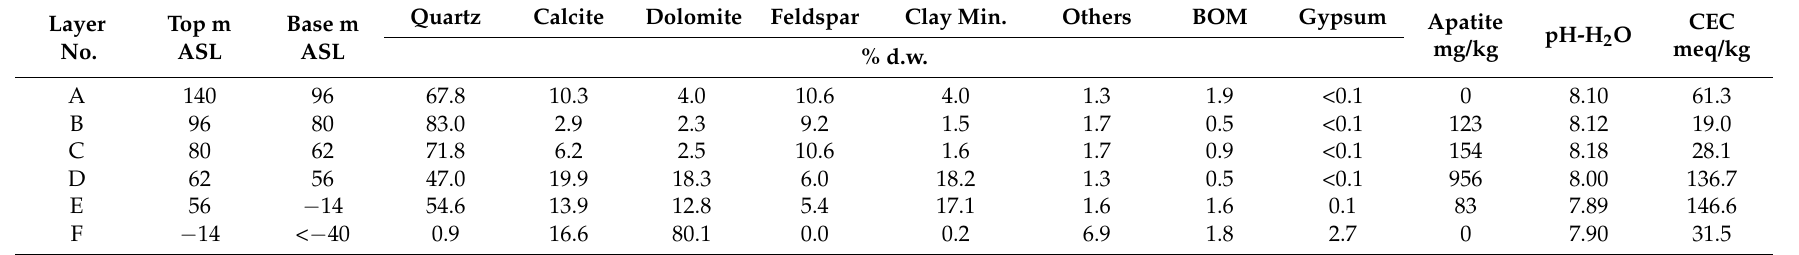
Table 1. Simplified geochemical stratification as derived from [23]. BOM = bulk organic material; CEC = Cation Exchange Capacity.